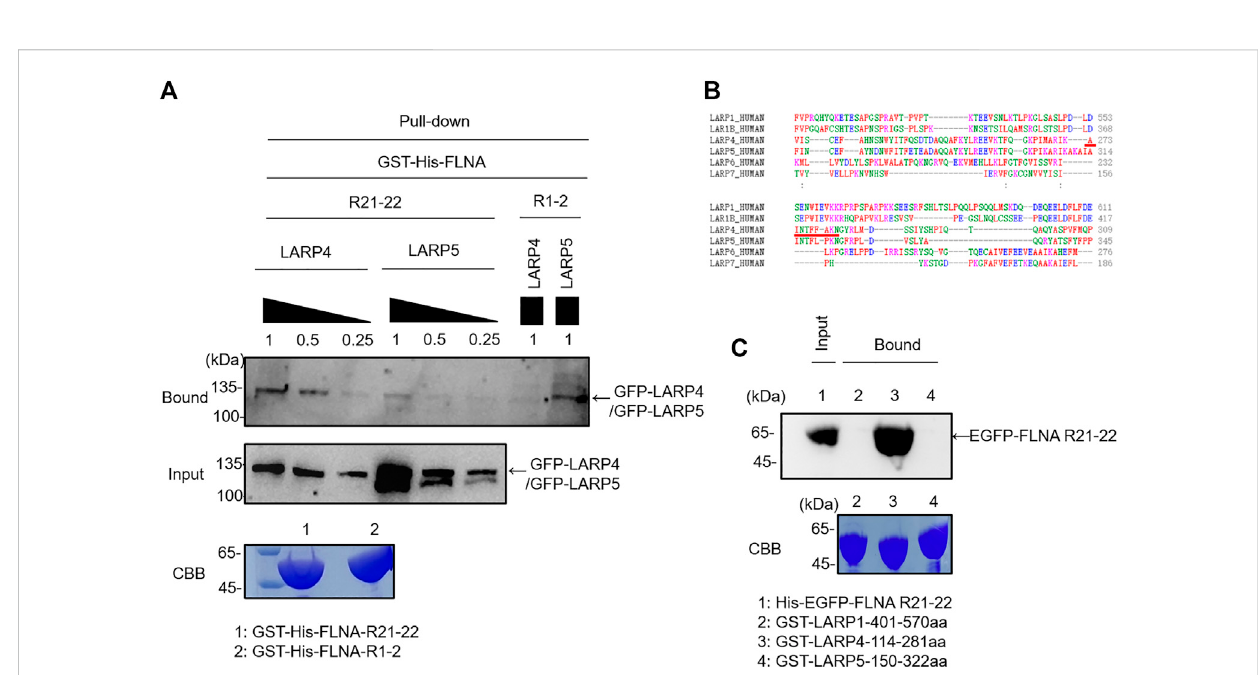
FIGURE 5 FLNA speci fi cally interacts with LARP4 but not with other LARPs protein. (A) GFP-LARP5 and GFP-LARP4 were expressed in HEK293A cells and comparable expressed protein was pulled down with GST-His-FLNA R21-22 or R1-2. Bound protein was detected by western blotting using rabbit anti- GFP antibodies. (B) Sequence alignment of the potential FLNA-binding motif in different LARP family proteins. Red underline indicates LARP4 FLNA- binding motif. (C) Corresponding La modules of LARP1, LARP4 and LARP5 were expressed as GST fusion protein and incubated with 2 μ M puri fi ed His-eGFP-FLNA R21-22. Bound protein was detected by western blotting using rabbit anti-GFP antibodies. 5 μ g of the puri fi ed GST fusion protein was loaded to the 9% SDS-PAGE gel for CBB staining.